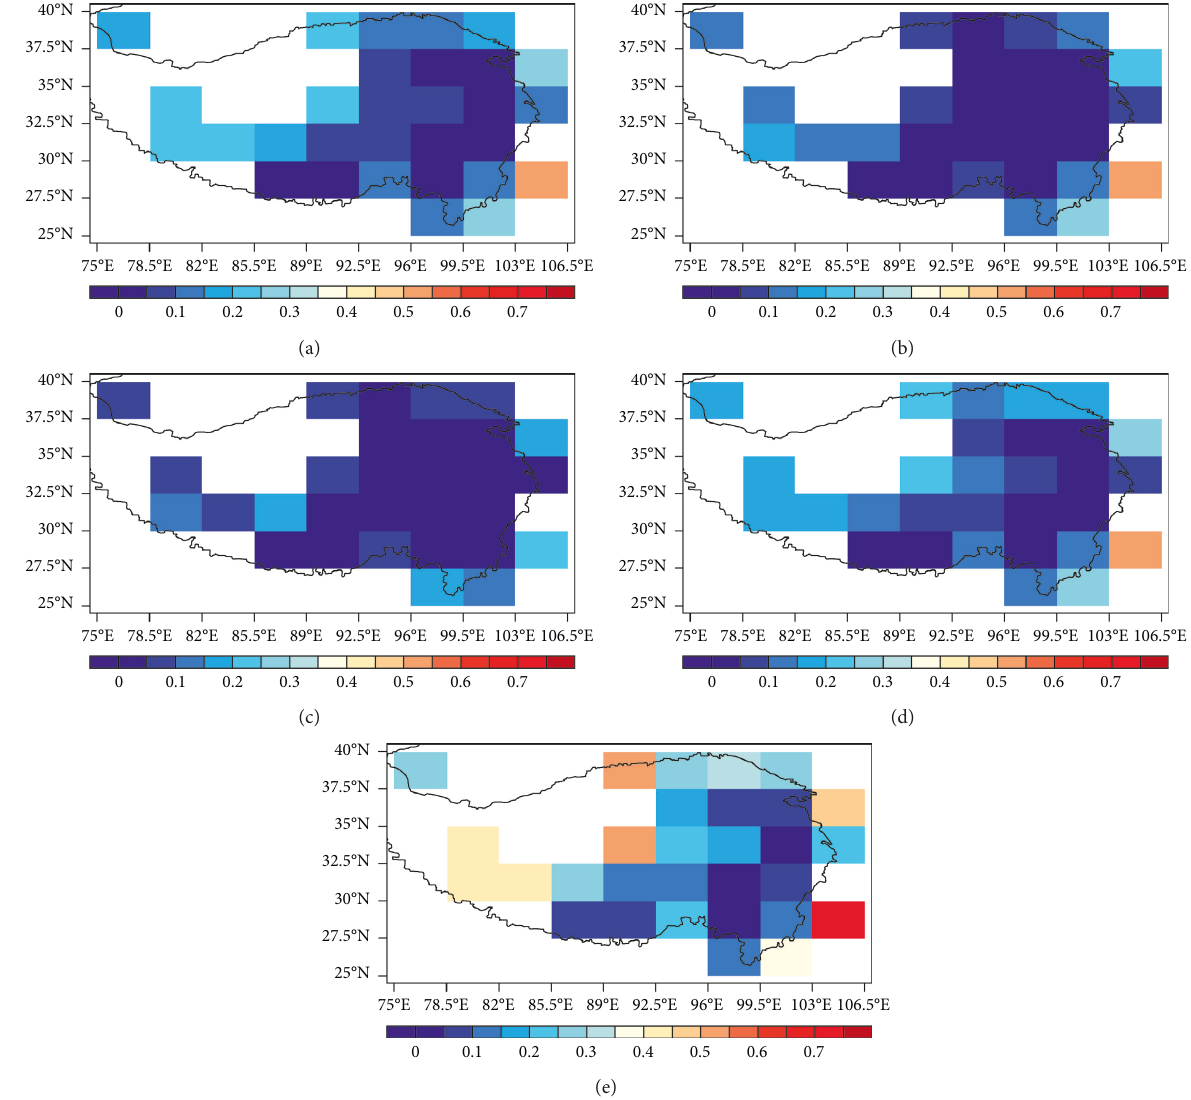
Figure 2: Spatial distributions of (a) annual and (b–e) seasonal mean sampling error variances ( ° C 2 ) in the TP averaged over 1979–2012: (a) annual; (c) summer; (b) spring; (d) autumn; (e)